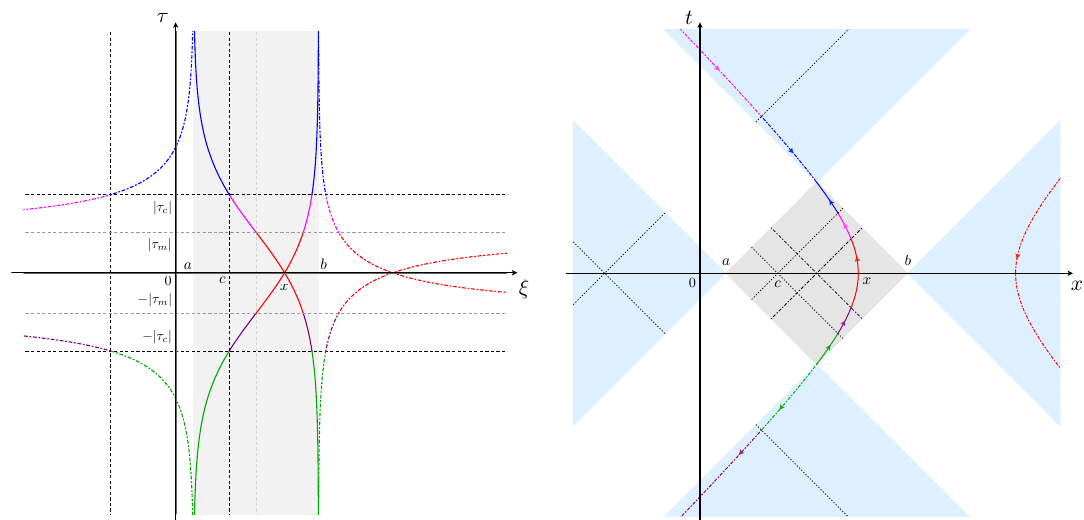
Left: the curves for ξ ( τ, x ) and ξ ( − τ, x ) (solid lines) and for ξ ( τ, z ξ ( − τ, z ( x )) (dot-dashed lines), obtained from (3.1), (3.8) and (3.4). Right: modular trajectory inv (solid line) in the diamond D A (grey region) and its image under the inversion (3.3) (dot-dashed line) in W A . The dot-dashed segment in D A provide the partition (3.2). The modular parameter τ grows along the curves as indicated by the arrows. The modular trajectory and its inversion provide the hyperbola